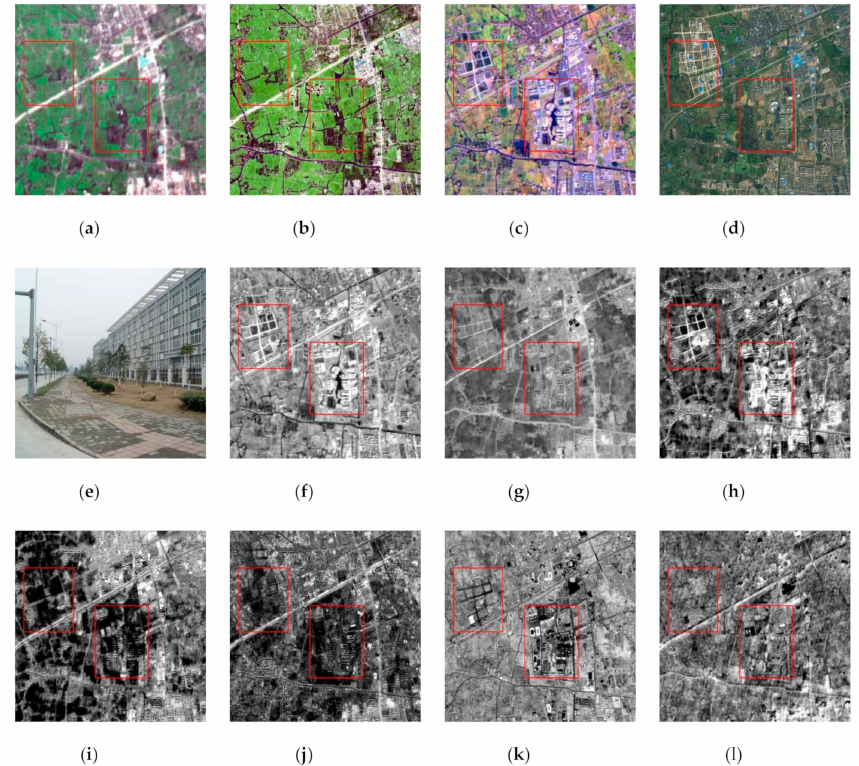
Figure 6. Example of multi-date PCA land use change enhancement, 2000–2003. ( a ) RGB composition image of SPOT-3 (2000); ( b ) color aerial photograph (2000); ( c ) RGB composition image of SPOT-5 (2003); ( d ) RGB composition image of IKONOS (2003); ( e ) field survey photo (2003); ( f – l ) from the first to seventh principal components